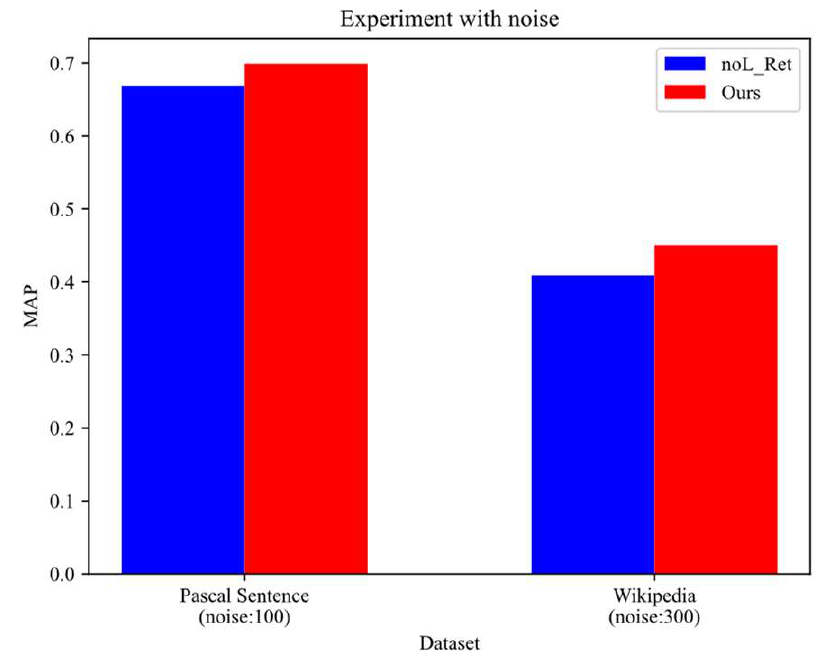
Figure 13. The mean mAP value of different cross-modal retrieval tasks on the Pascal Sentence and Wikipedia datasets, which contain 100 and 300 noise samples, respectively.